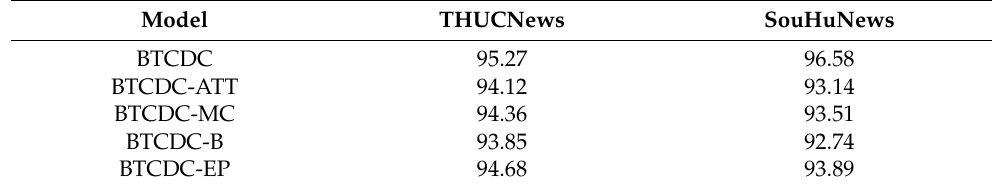
Table 5. Accuracy of each model on the ablation experiment.